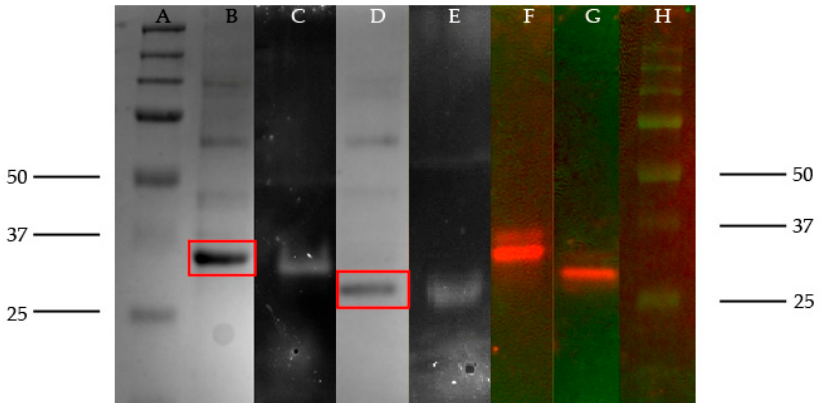
Figure 2. ( A ) Prestained all blue Precision Plus Protein™ standards molecular weight marker. ( B ) SDS-PAGE results for proROL (square). ( C ) Zymogram for proROL lipase. ( D ) SDS-PAGE results for rROL lipase (square). ( E ) Zymogram for rROL lipase. ( F ) Western blot results for proROL lipase. ( G ) Western blot results for rROL lipase. ( H ) Precision Plus TM all blue standards molecular weight marker.